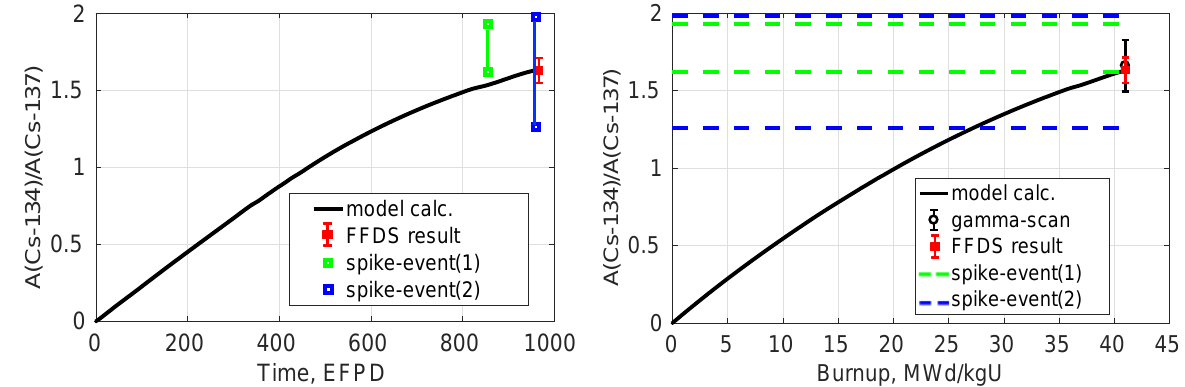
Figure 8. TVS-2M #3, leaking rod: comparison of 134 Сs/ 137 Cs activity ratio in fuel as function of the FA operation time (left) and burnup (right) with the results of FFDS testing and